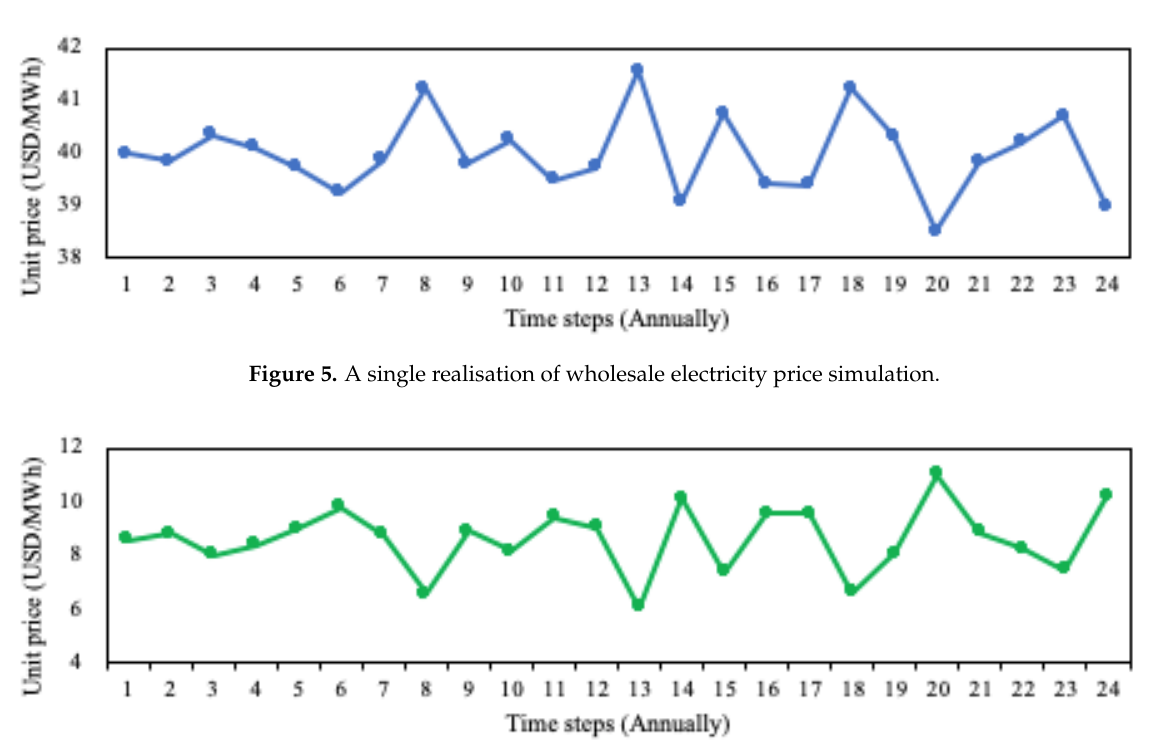
Figure 7. A single realisation of CO 2 price simulation. One hundred stochastic time-series simulation cash flow realisations were generated per configuration. One such realisation is presented in Figure 8, illustrating the uncer- tainty in future cash flows for configuration BL–50 using SP–4 conditions. Figure 8. A single realisation of the cash flow series for baseline configuration BL–50.